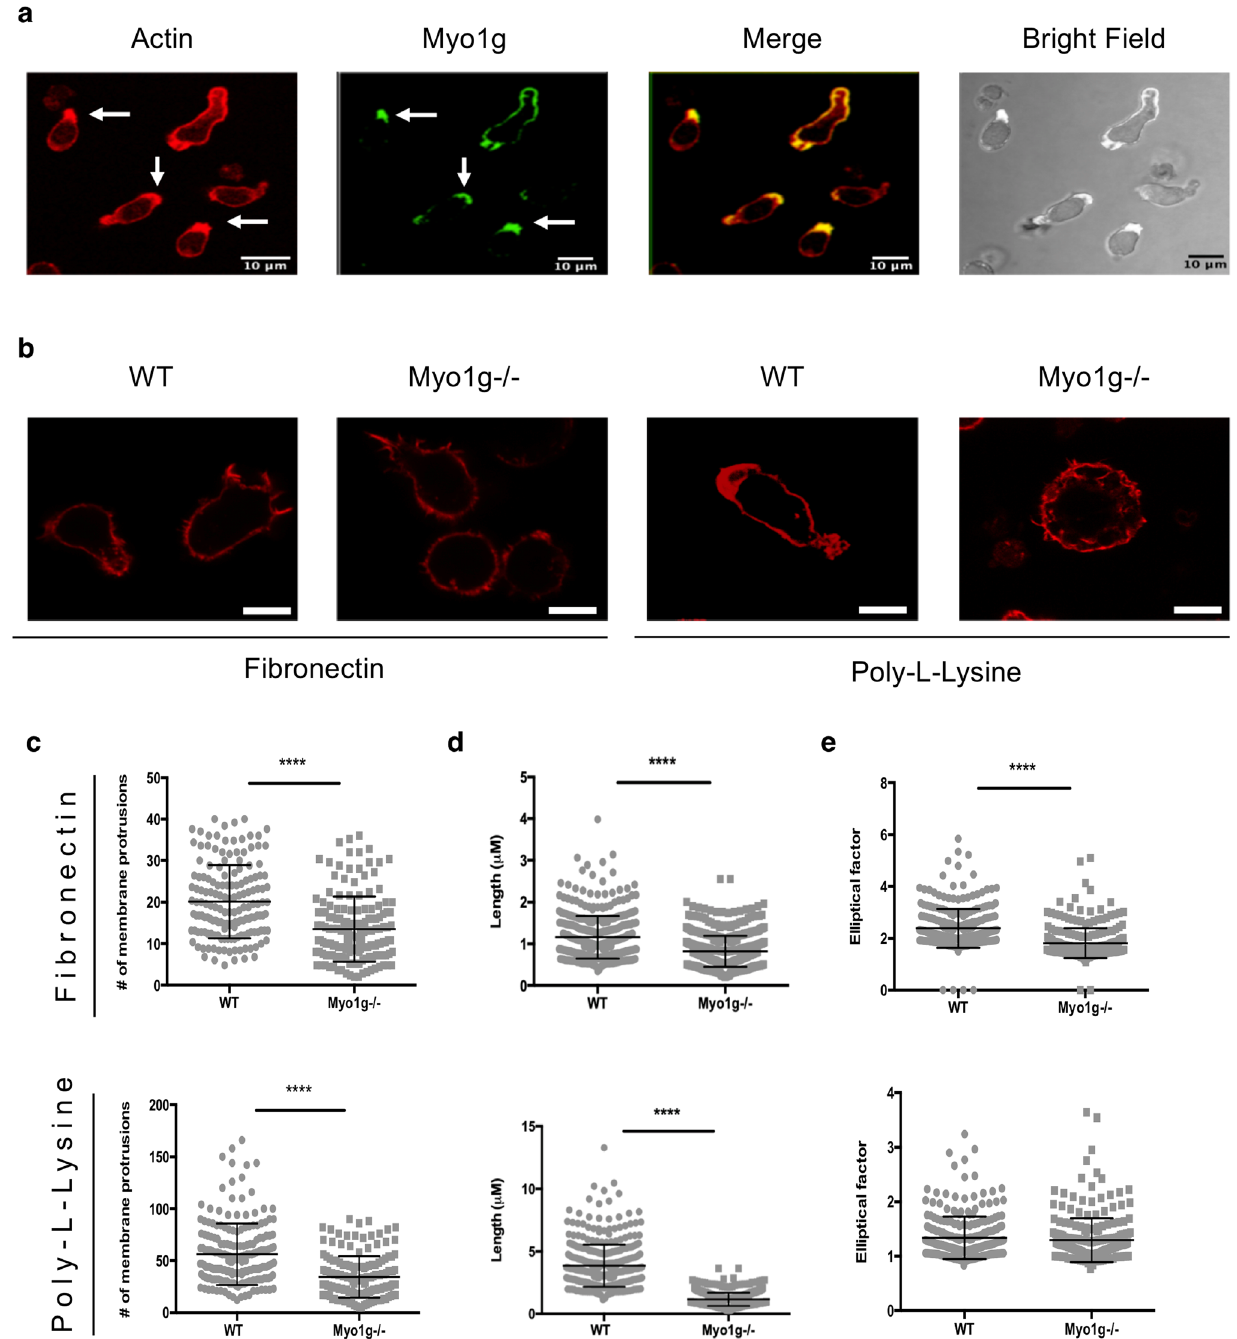
Figure 4. The absence of Myo1g affects the migratory phenotype of activated B lymphocytes. ( a ) Representative images (40 × objective) of migrating LPS + IL-4 activated WT B cells in a CXCL13 gradient. Myo1g is polarized toward the leading edge (white arrows). ( b ) Representative images (63 × objective) of activated WT or Myo1g −/− B lymphocytes migrating on Fibronectin or Poly-l-Lysine coated slides in a CXCL13 gradient 30 min, followed by staining with TRITC-Phalloidin. Scale bars 5 μm. n = 3. ( c ) Measurement of the number of membrane protrusions, ( d ) length of protrusions, and ( e ) elliptical factor of CXCL13-stimulated WT or Myo1g −/− B lymphocytes migrating on Fibronectin and Poly-l-Lysine coated slides. Data correspond to three independent experiments. Data are presented as mean ± s.d. ****P <